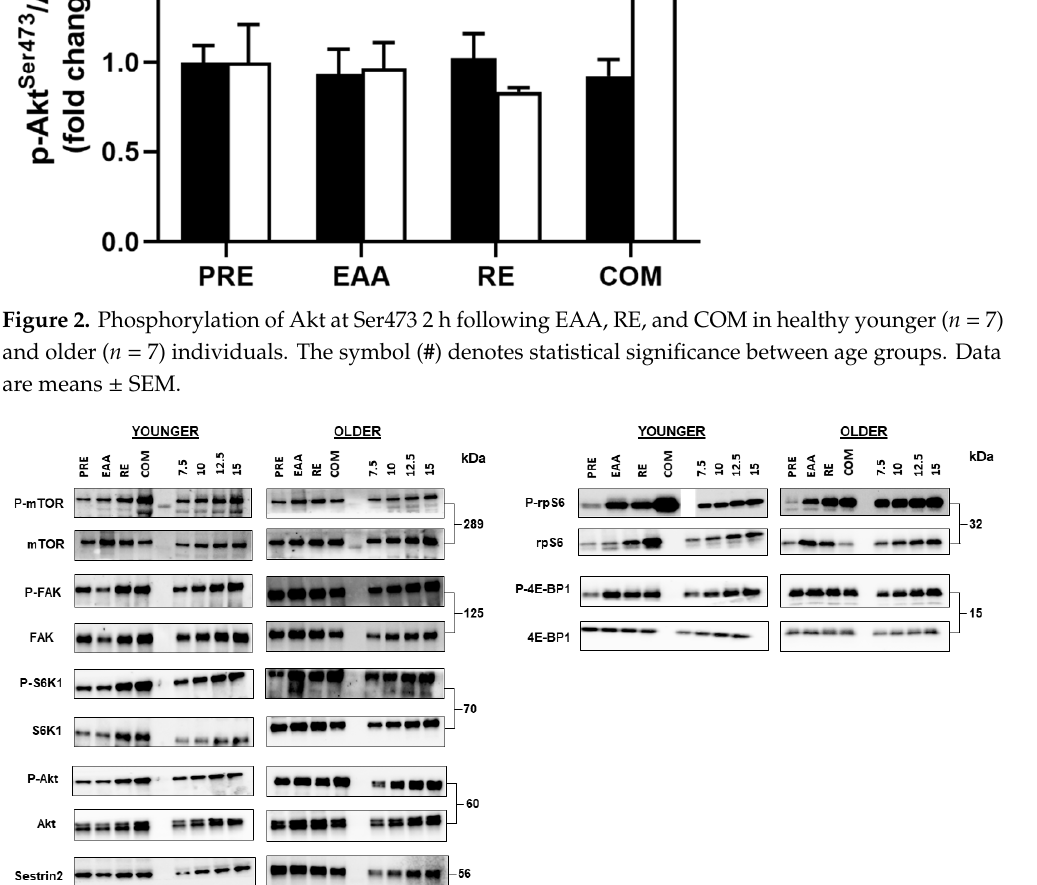
Figure 3. Representative blots for each total and phosphoprotein. Blots are in the following order: baseline, EAA, RE, and COM. The fifth lane is occupied by the protein ladder. To the right of the experimental blots, the loading controls (calibration curves) are shown (i.e., 7.5, 10, 12.5, and 15 μ L of protein).